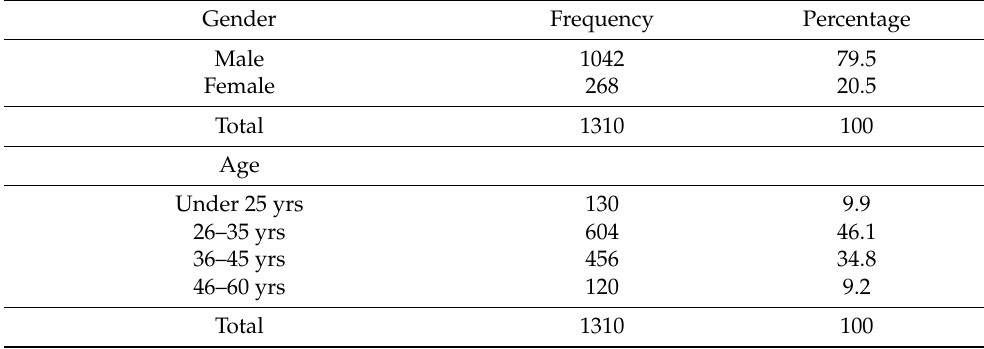
Table 3. Description of